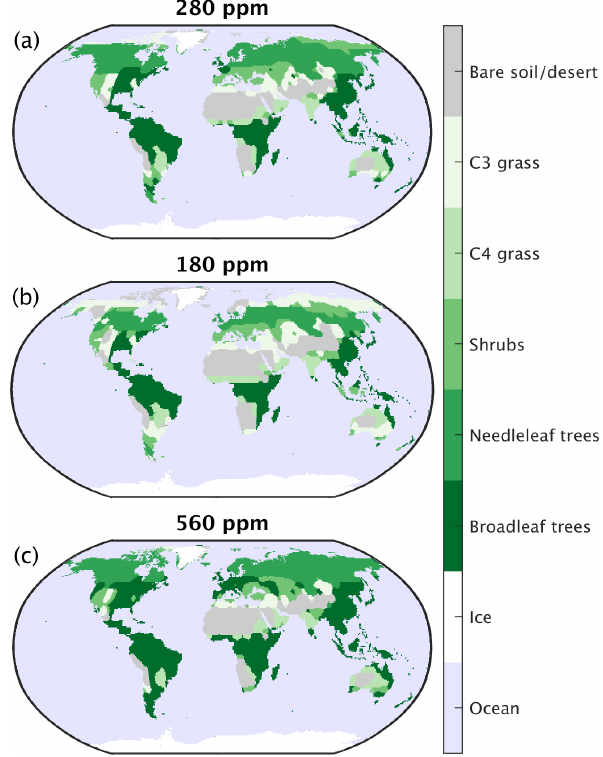
Figure 27. Simulated dominant plant functional types at equilib- rium for (a) the pre-industrial control, (b) 180ppm and (c) 560ppm of atmospheric CO 2